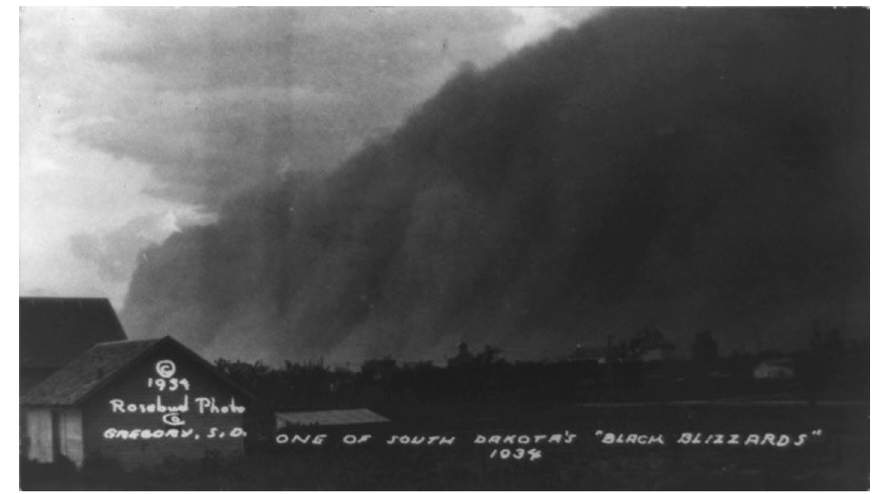
Fig. 1 A ‘ black blizzard ’ dust storm in South Dakota. May, 1934. (Source: the Library of Congress, Prints & Photographs Division, FSA/OWI Collection ,